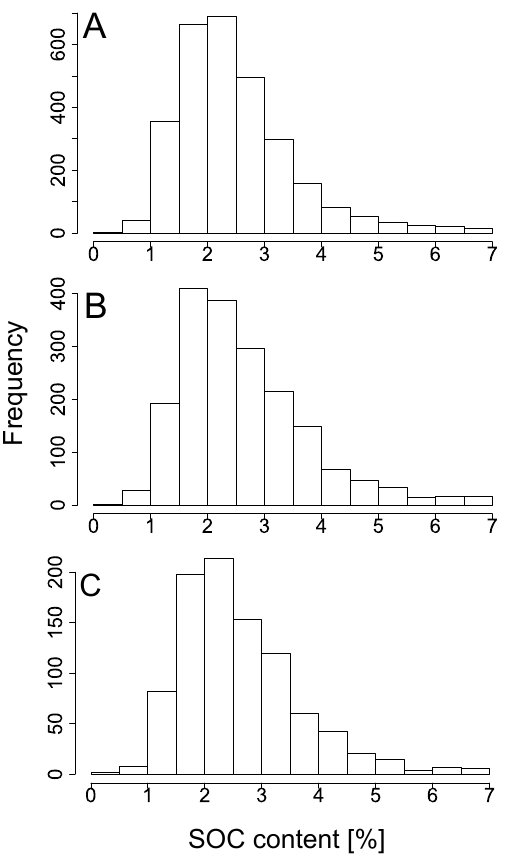
Figure 1. Histogram of measured carbon concentration (0.5% C increments) for (a) Inventory I, (b) Inventory II and (c) Inventory